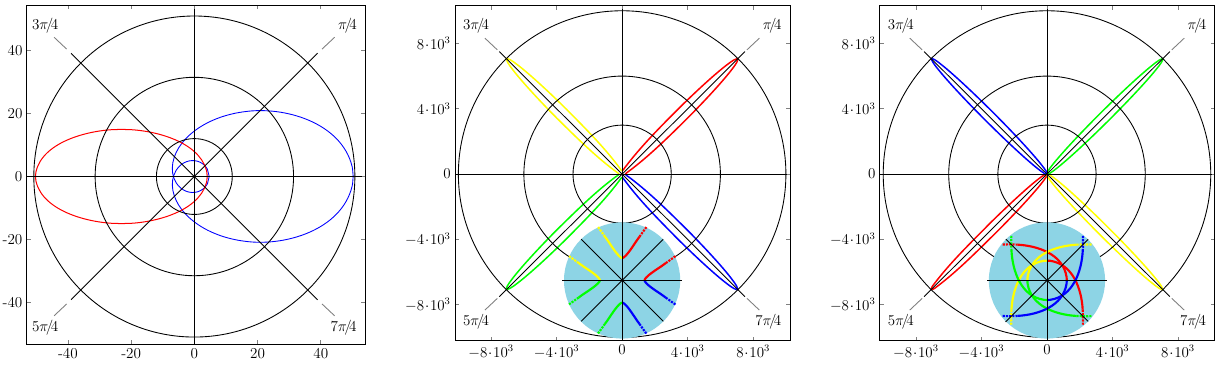
Fig. 2 Theshapeoforbitswithdifferentparametersanddifferentnum- bers of oscillations per revolution. They all have the apocentre radius whichisapproximatelythesameasthatfortheSchwarzschildspacetime in Fig. 1, r max ≈ 50 . 3, but they all have a negative angle of precession. Leftpanel: a = 3, J = 0 . 094, E = 0 . 9606, r min = 0 . 37, r max = 50 . 37,